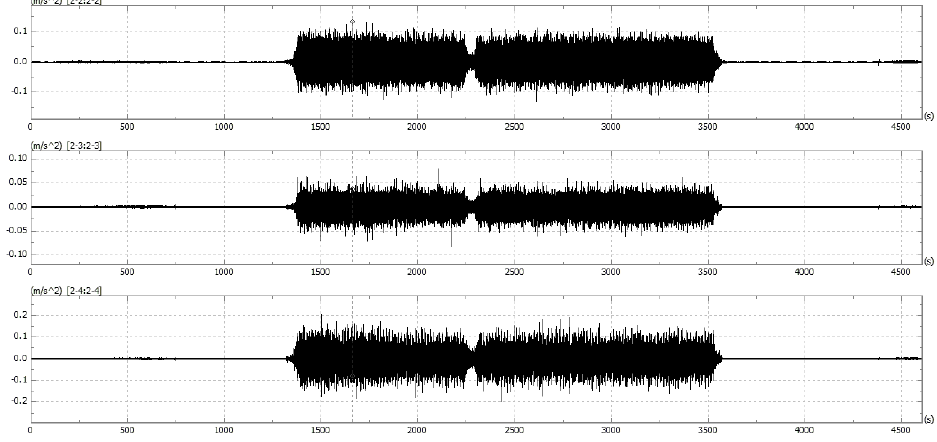
Figure 7. Time-domain curve of monitoring point Z-4 03.